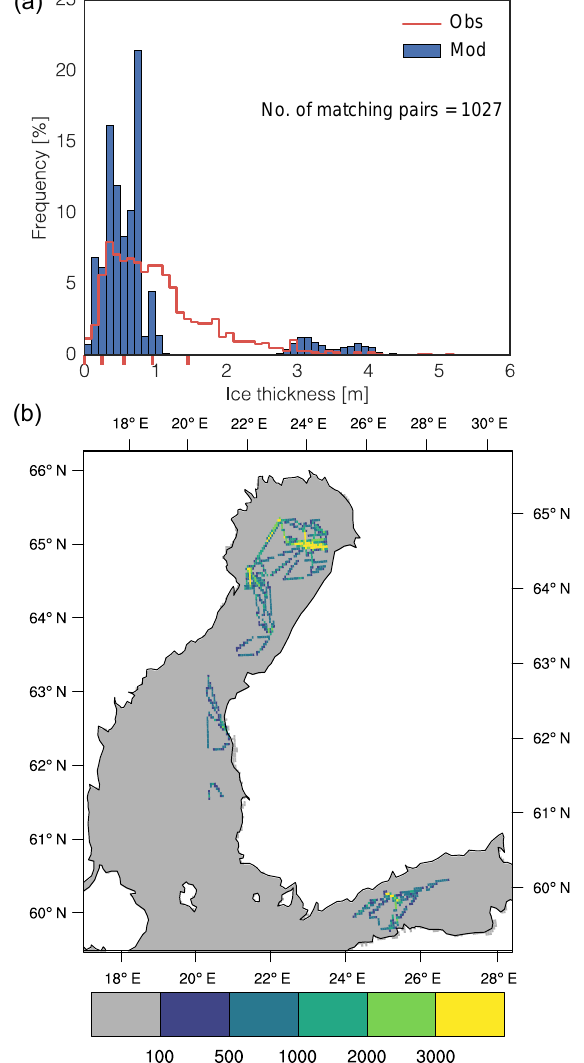
Figure 10. (a) Sea-ice thickness distributions calculated from the gridded EM data (red) and the simulation (blue). (b) shows the num- ber of sub-grid observations of the gridded EM data. The red tick lines in (a) show the limits for the five ice categories. Note that the upper limit of the last ice category – which is unbounded – is not